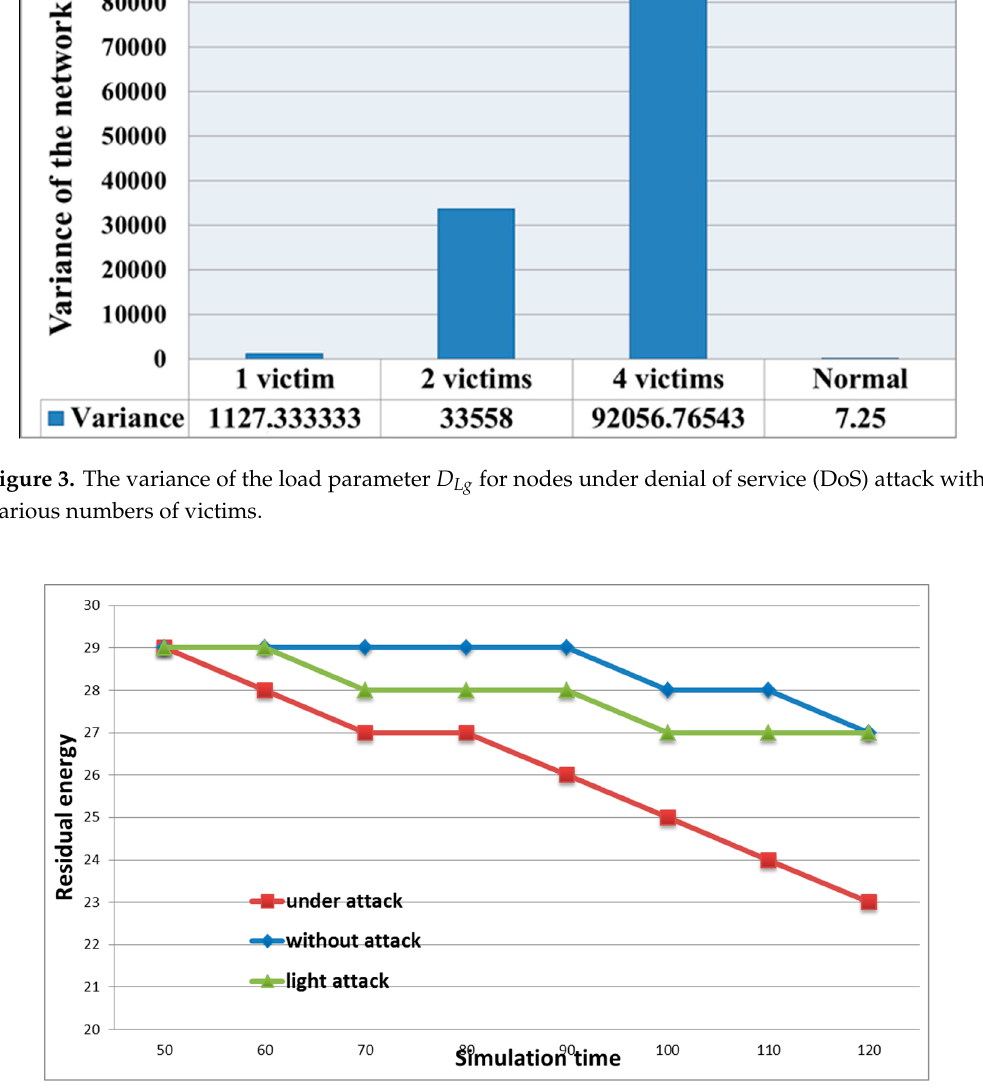
Figure 4. Changes in the residual energy level depending on the traffic load of network nodes.